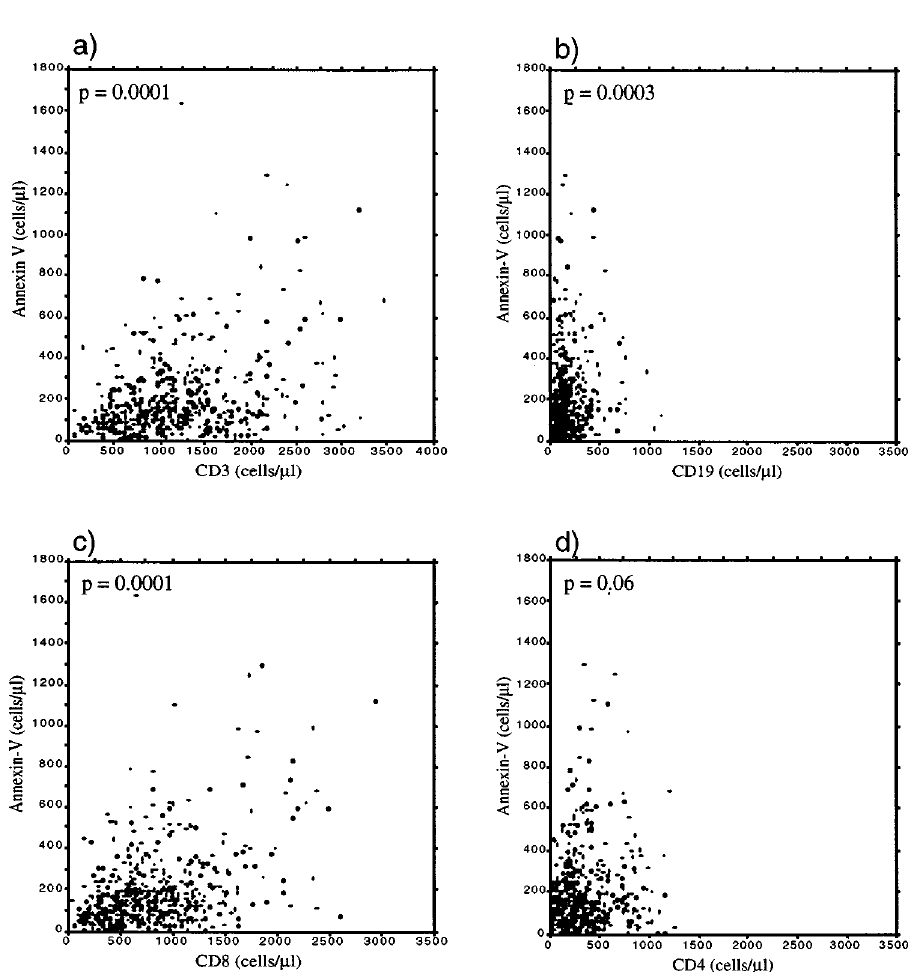
Fig. 2. Relationships between the annexin-V-positive cell count (cells/ (cid:22) l) and the absolute celll number (cells/ (cid:22) l) positive for CD3, CD19, CD8 and CD4 distinct subpopulations. The Spearman correlation significance ( p ) is indicated on the top of each figure. The Spearman rank correlation coefficients ( r s ) are: 0.31; 0.16; 0.35; and 0.09 for the correlations plotted in (a) (b) (c) and (d), respectively. Only in plot (d) there was no significant correlation between CD4/A-V, as indicated by p = 0 :